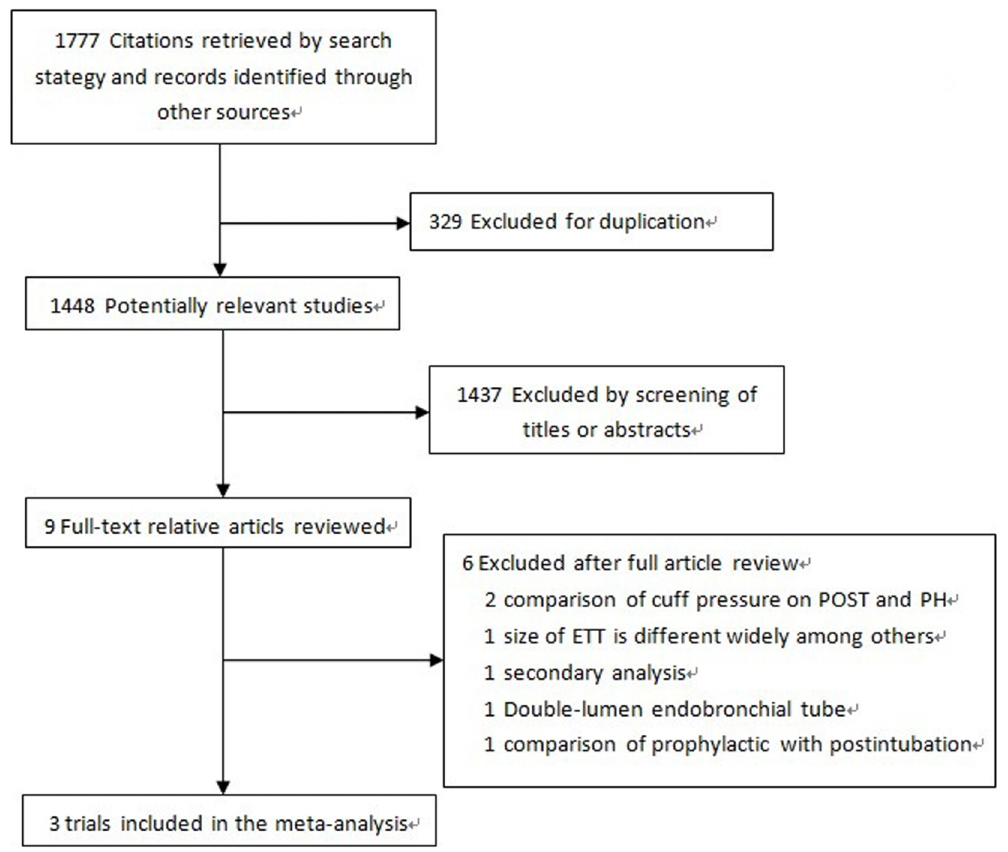
Figure 1. Flow chart detailing retrieved, excluded, assessed, and included trials.